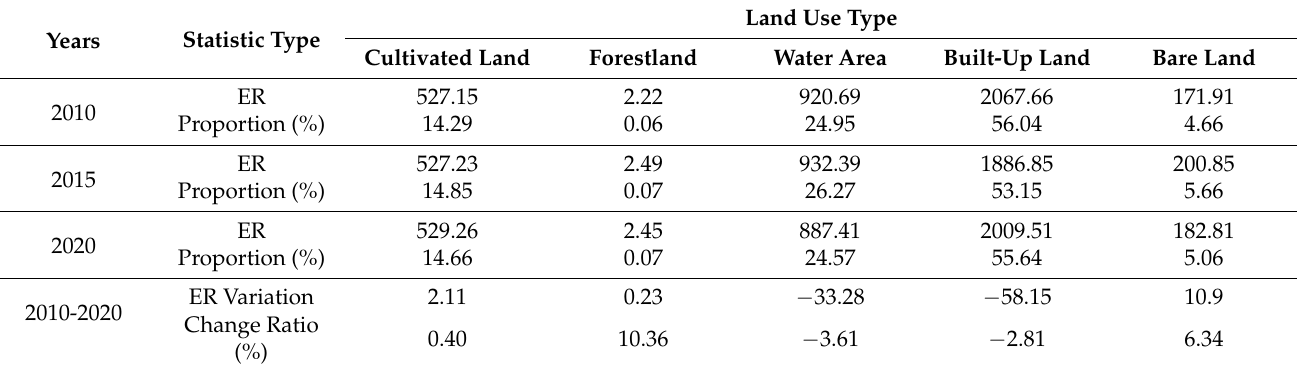
Table 6. Changes and contributions of the ER in Peixian.